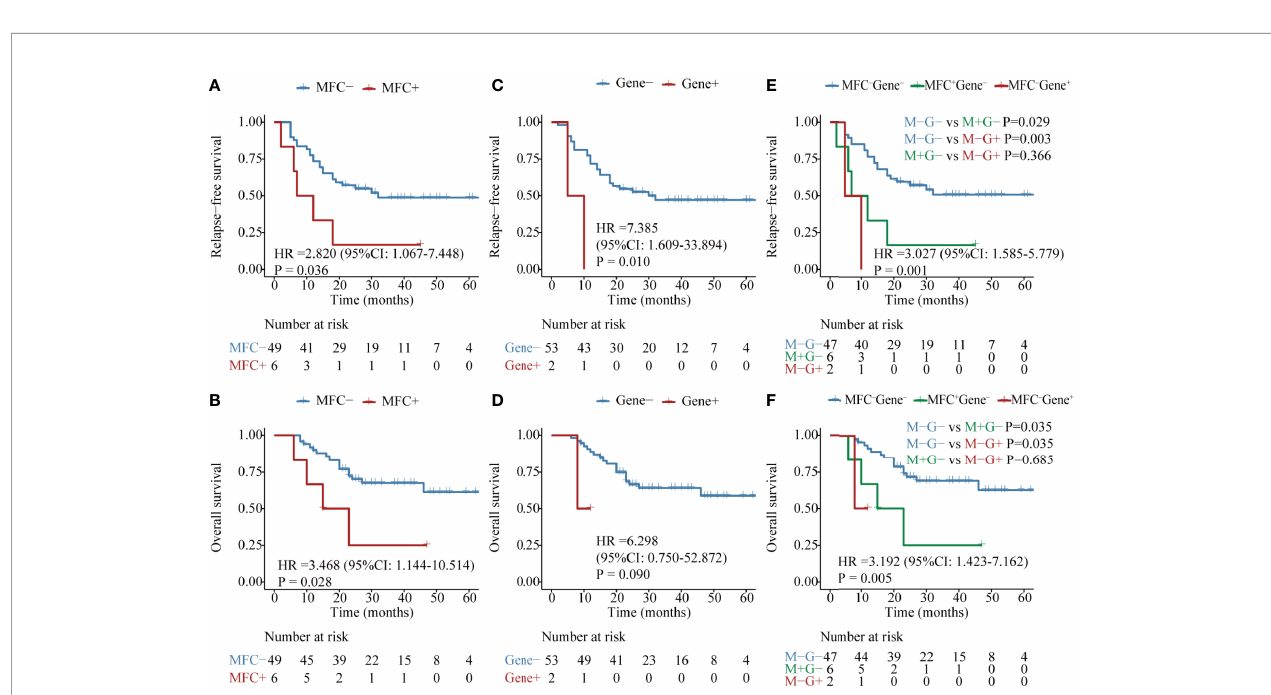
FIGURE 5 | Kaplan – Meier curves for probability of relapse-free survival (RFS) and overall survival (OS) in AML patients with NPM1 mutations. (A, B) RFS and OS based on MFC MRD status post-consolidation. (C, D) RFS and OS based on NPM1 mutations status post two consolidation cycles. (E, F) RFS and OS based on MFC MRD status and Gene MRD status post two consolidation